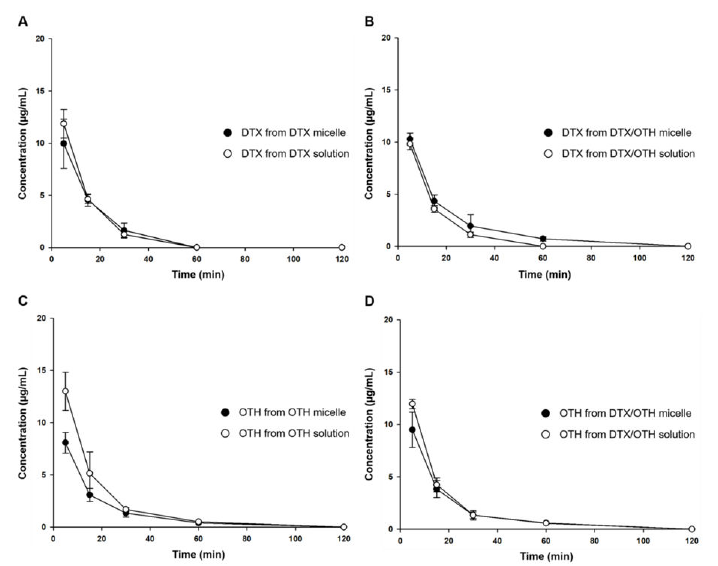
Figure 5. Plasma concentration–time profiles after intravenous injection of docetaxel (DTX) and osthol (OTH). ( A ) DTX profile in DTX-loaded mPEG- b -PCL micelles and DTX solution, ( B ) DTX profile in DTX/OTH-loaded mPEG- b -PCL micelles and DTX/OTH solution, ( C ) OTH profile in OTH-loaded mPEG- b -PCL micelles and OTH solution, and ( D ) OTH profile in DTX/OTH-loaded mPEG- b -PCL micelles and DTX/OTH